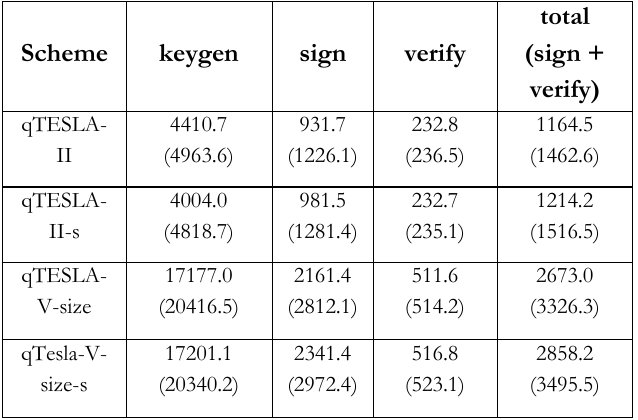
Table 4. Second Round Optimized Implementation tests for 5000 iterations.